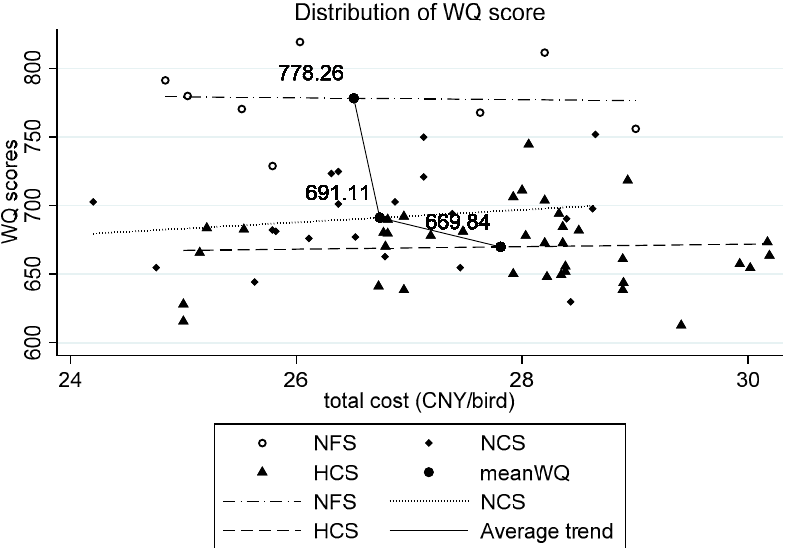
Figure 2. Distribution of WQ scores based on cost of per delivered broiler. NFS = normal floor system, NCS = normal cage system, and HCS = high standard cage system.